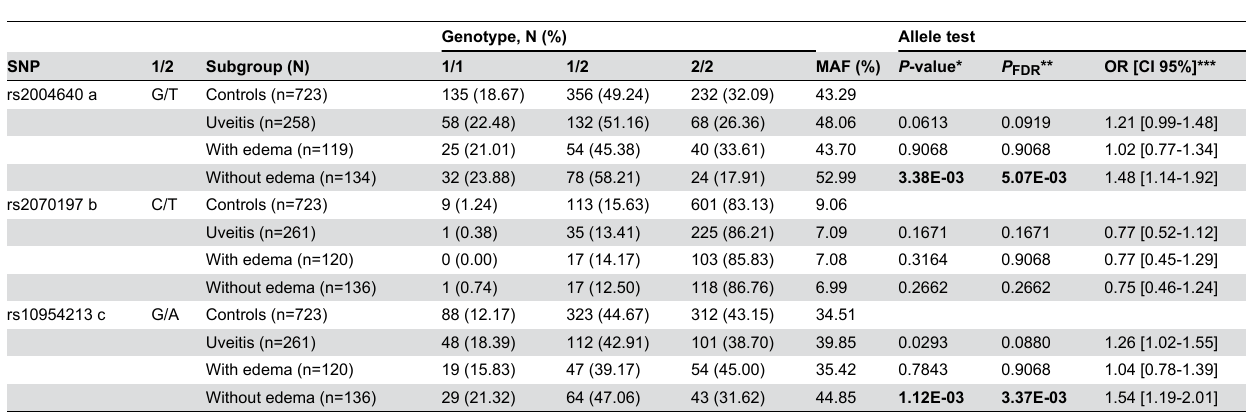
Table 2. Genotype and minor allele frequencies of IRF5 genetic variants in uveitis patients and healthy controls.